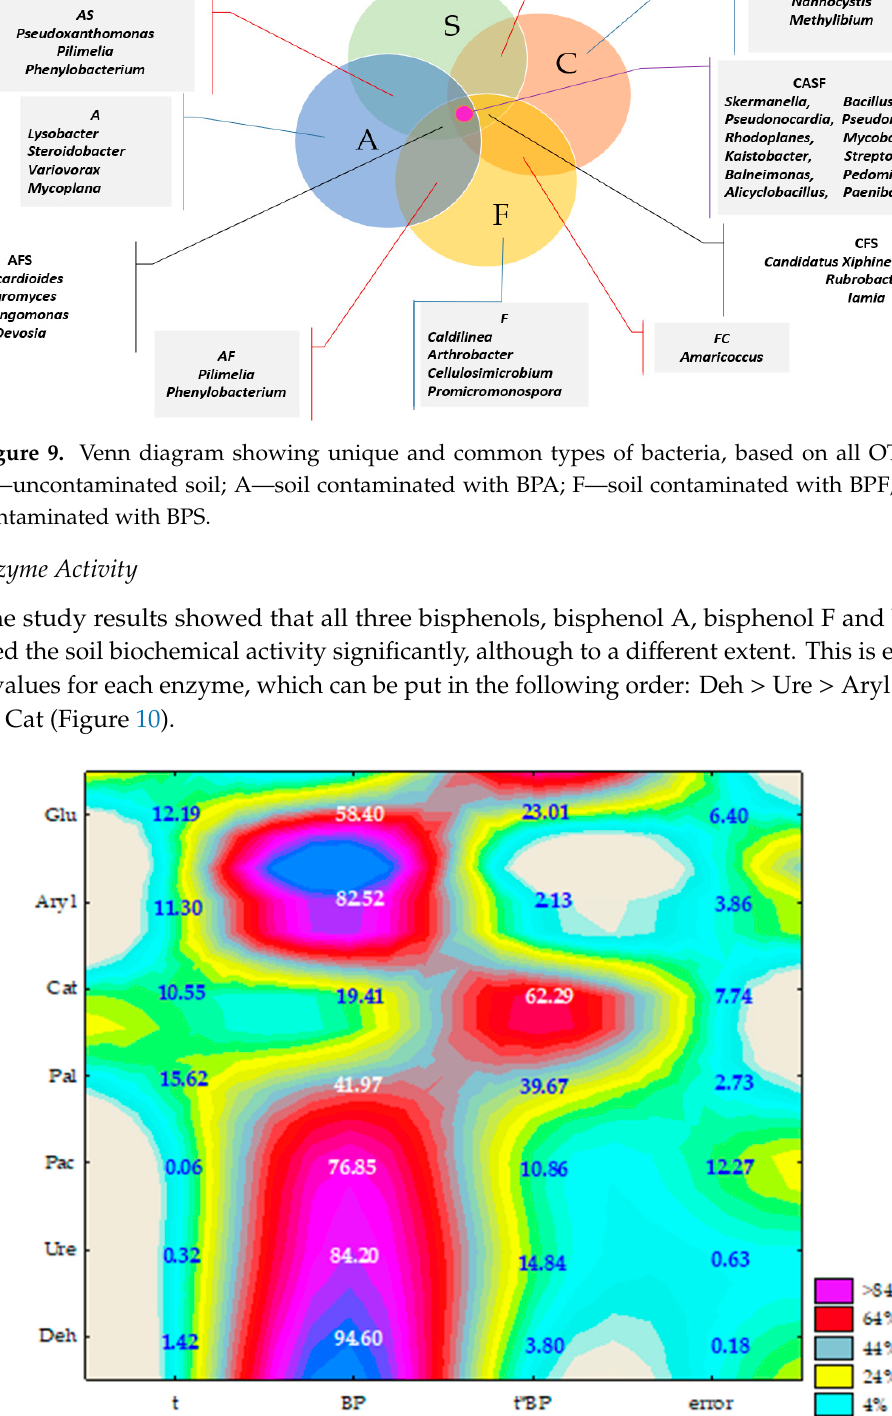
Figure 10. The share of independent variables in the evolution of the soil enzyme activity ( η 2 ): t—time, BP—kind of bisphenol; time*kind of bisphenol; Deh—dehydrogenases; Ure—urease, Pal—alkaline phosphatase, Pac—acid phosphatase, Aryl - arylsulphatase, Glu— β -glucosidase, (two-way analysis of variance, ANOVA, at p < 0.05).